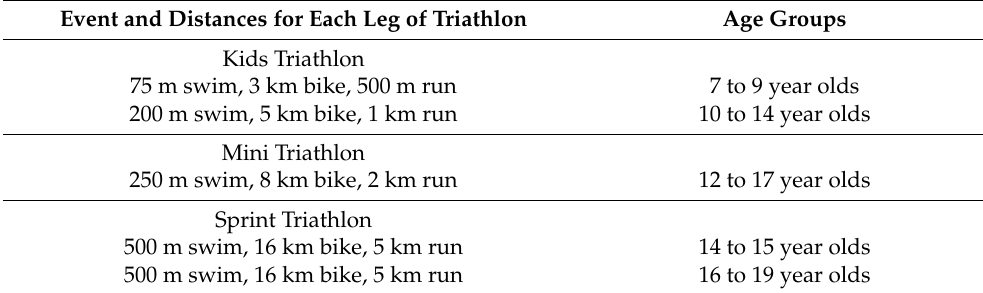
Table 1. Event and age group categories at the junior triathlon competition held in Melbourne, Victoria,